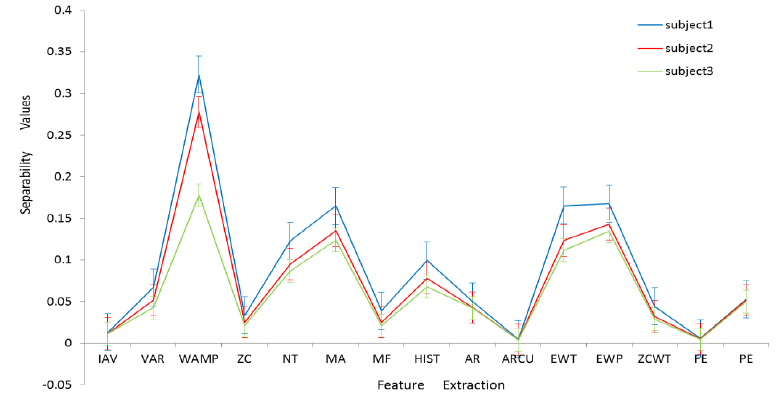
Figure 4. Class separability index values (Error bar: standard error).